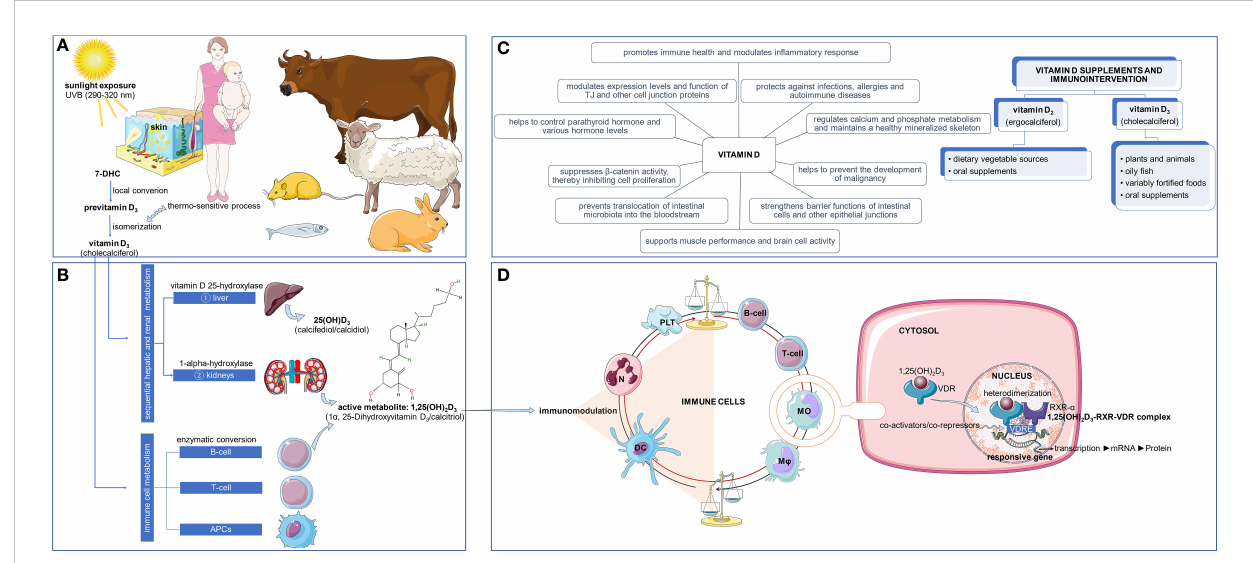
FIGURE 1 The complexity of vitamin D3: synthesis, metabolism, mechanism of action, and immunointervention. The bioactive form of vitamin D 3 plays an important role in the modulation of immune system. The skin of humans and some animals synthesize vitamin D 3 when exposed to ultraviolet B (UVB) radiation (290 – 320 nm) by acting on 7-dehydrocholesterol (7DHC) (A) . After undergoing enzymatic processes in the liver and kidneys, vitamin D 3 is then metabolized into its active form, 1,25(OH) 2 D 3 (1 a , 25-Dihydroxyvitamin D 3 /calcitriol) by vitamin D 25-hydroxylase and 1-alpha- hydroxylase, respectively. Some immune cells, including B-cells, T-cells and antigen presenting cells (APCs), are also able to transform vitamin D 3 into its active metabolite through a process of enzymatic conversion. (B) . Not only does vitamin D 3 perform many vital roles, it has been shown to possess powerful effects that can control immune function, allowing it to be utilized in immunologic interventions to keep the immune system functioning optimally and to correct any existing vitamin D de fi ciencies (C). The immune effects of vitamin D 3 are ensured by its active metabolite, i.e., 1,25(OH) (VDRE) on the DNA (D) . DC, dendritic cell; MO, monocyte; M j , macrophage; N, neutrophil; PLT, platelet; TJ, tight junction. Some illustrations were sourced from the Servier Medical Art